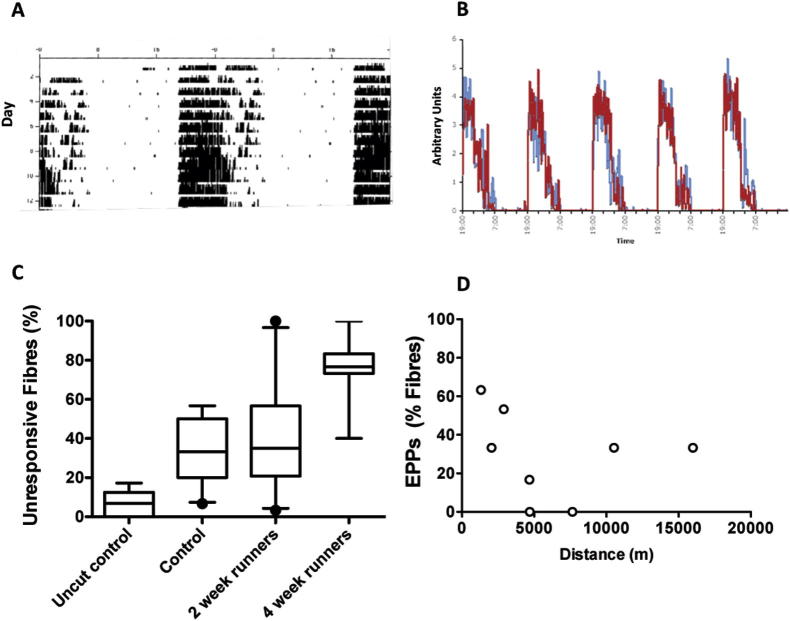
Prolonged self-motivated exercise sensitizes NMJ to axotomy-induced degeneration. (A) Representative circadian activity pattern in a WldS mouse. Each horizontal trace is a record of activity over a 24 h period, divided into 12 h of light and 12 h of darkness. Each vertical line is proportional to the number of wheel revolutions. (B) Integrated activity of WldS mice (red) and C57Bl6 mice (blue) (n = 6 mice in each case) shows no discernible difference in the pattern or amount of circadian activity in the two strains of mice. As expected, most activity was in the dark. (C) Box-whisker plots of incidence (median and interquartile range; outliers >90 percentile shown as dots) of unresponsive FDB muscle fibers (neither MEPPs, nor evoked EPPs observable on tibial nerve stimulation in isolated preparations) in four groups of mice: controls with no nerve section; WldS controls with no running wheels, 5 day post-axotomy; WldS mice with provision of running wheels for 2 weeks, then 5 days post axotomy; WldS mice with provision of running wheels for 4 weeks, then 5 days post axotomy. n = 7–11 muscles per group. (D) Plot of incidence of Responsive fibers (evoked EPPs) versus recorded mean diurnal running wheel activity, averaged over 4 weeks and assayed 5 days post axotomy. While there was no clear evidence of regression or correlation, mice running the least distance had stronger levels of synaptic protection than those running the most. (For interpretation of the references to color in this figure legend, the reader is referred to the web version of this article.)